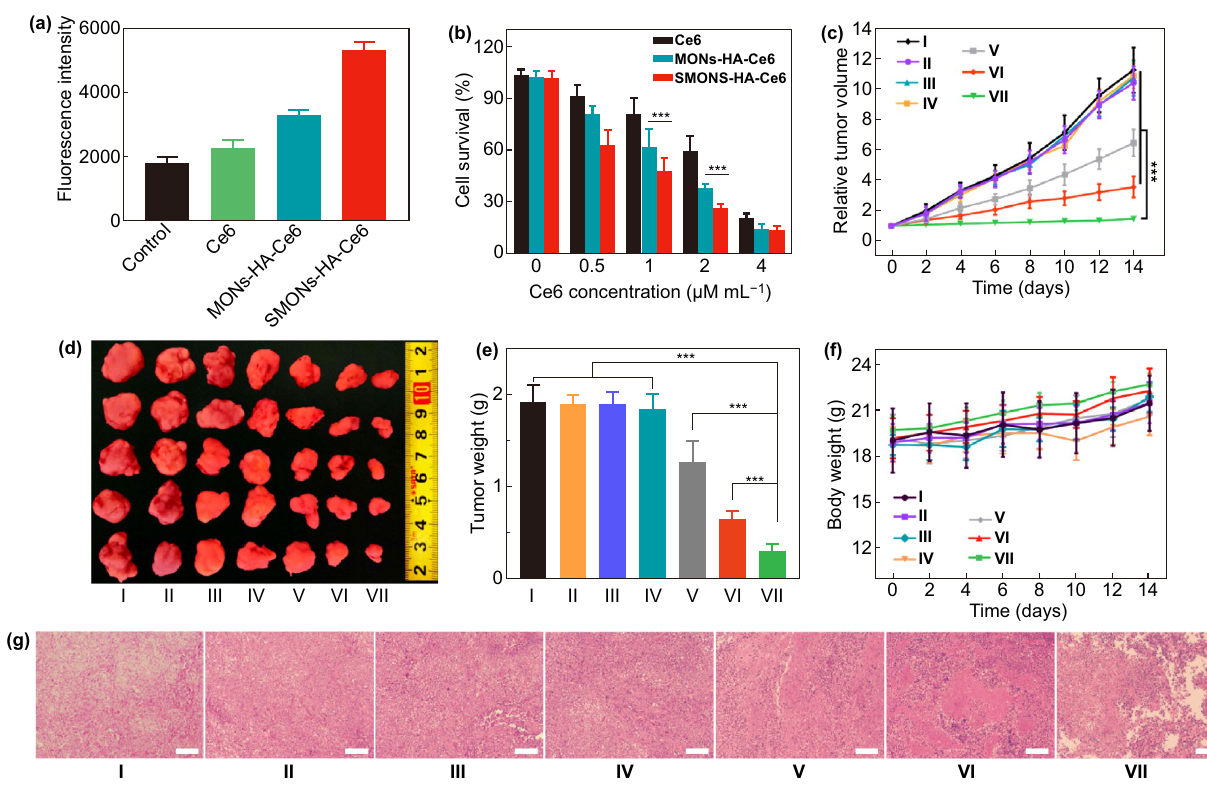
Fig. 6 PDT efficacy. a Fluorescence intensity of DCF in MCF-7 cells, which incubated with different agents and then received laser irradia- tion (660 nm, 0.5 W cm −2 , 5 min), measured by a microplate reader. b Viability of MCF-7 cells co-incubated with different concentrations of Ce6, MONs-HA-Ce6, SMONs-HA-Ce6 for 24 h and then irradiated with laser (660 nm, 0.5 W cm −2 ) for 5 min. c Tumor growth curves of dif- ferent groups ( n = 5 mice per group). d Tumor photographs and e tumor weights at the end point after various treatments. f The body weights of MCF-7 tumor-bearing mice during treatments. g H&E staining images of tissue sections from tumors of different groups at 24 h after irra- diation. Scale bars, 100 µm. *** P < 0.001. I: PBS group; II MONs-HA-Ce6 group; III: SMONs-HA-Ce6 group; IV: PBS + laser group; V: free Ce6 + laser group; VI: MONs-HA-Ce6 + laser group; VII: SMONs-HA-Ce6 + laser